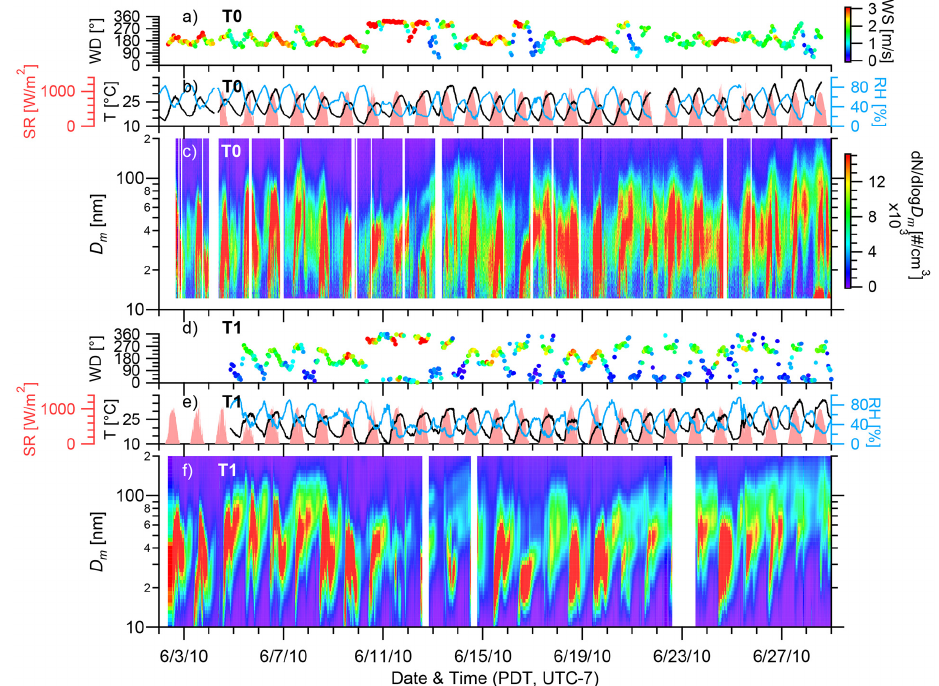
Figure 1. Time series of (a, d) wind direction colored by wind speed, (b, e) broadband solar radiation, temperature and relative humidity, and (c, f) particle size distributions at the T0 and T1 sites.